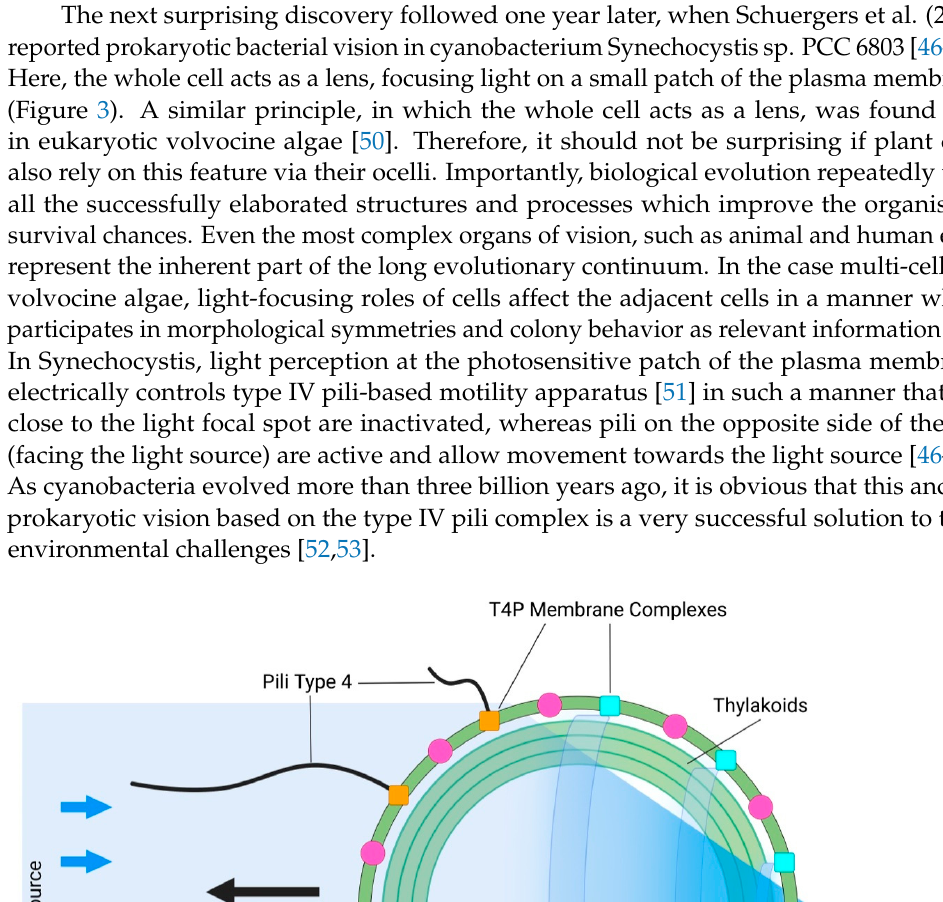
Figure 2. Algal Ocelloid of Dinoflagellates . Camera-like ocelloid of warnowiid dinoflagellates is composed of cornea-like mitochondrion enclosing hyaloplasm acting as lens and chloroplast-based retinal body. Similarly, as in the algal eyespot, the chloroplast plays the central role in the microbial vision. Adapted according [43].